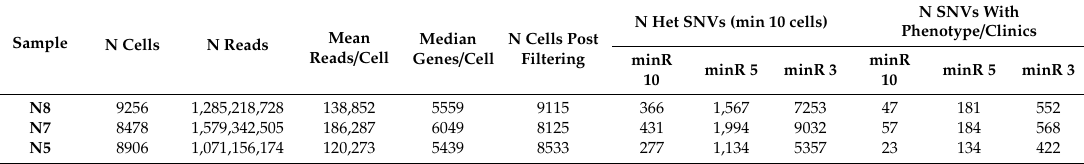
Table 1. Summary statistics for the scRNA-seq data of the three ADSC samples. We estimated the number of single nucleotide variant (SNV) loci covered in at least 10 individual cells (per donor) with different thresholds for the minimum number of unique reads (minR), and from those, the number of SNVs associated with a phenotype (phenotype and clinical associations were extracted via SeattleSeq database annotation (v13, dbSNP build 153)).